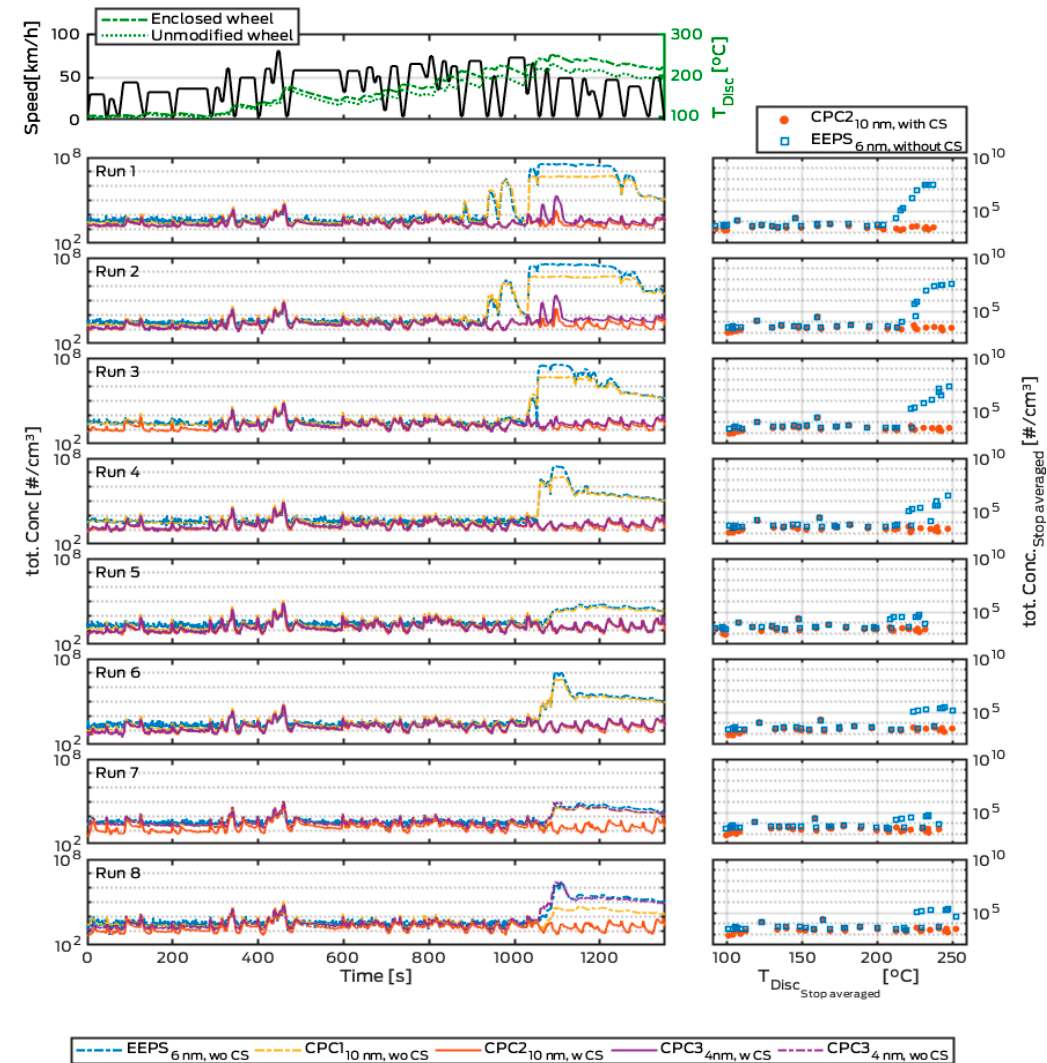
Figure 4. Overview of the PN emissions during chassis dyno LACT-20 repeatability measurement. Top—Velocity trace and brake disc temperatures. Left—Time trace. Solid lines refer to measurements with CS and dashed w/o CS. Right—Stop averaged total PN concentration for each run plotted against mean brake disc temperature per stop with and without CS